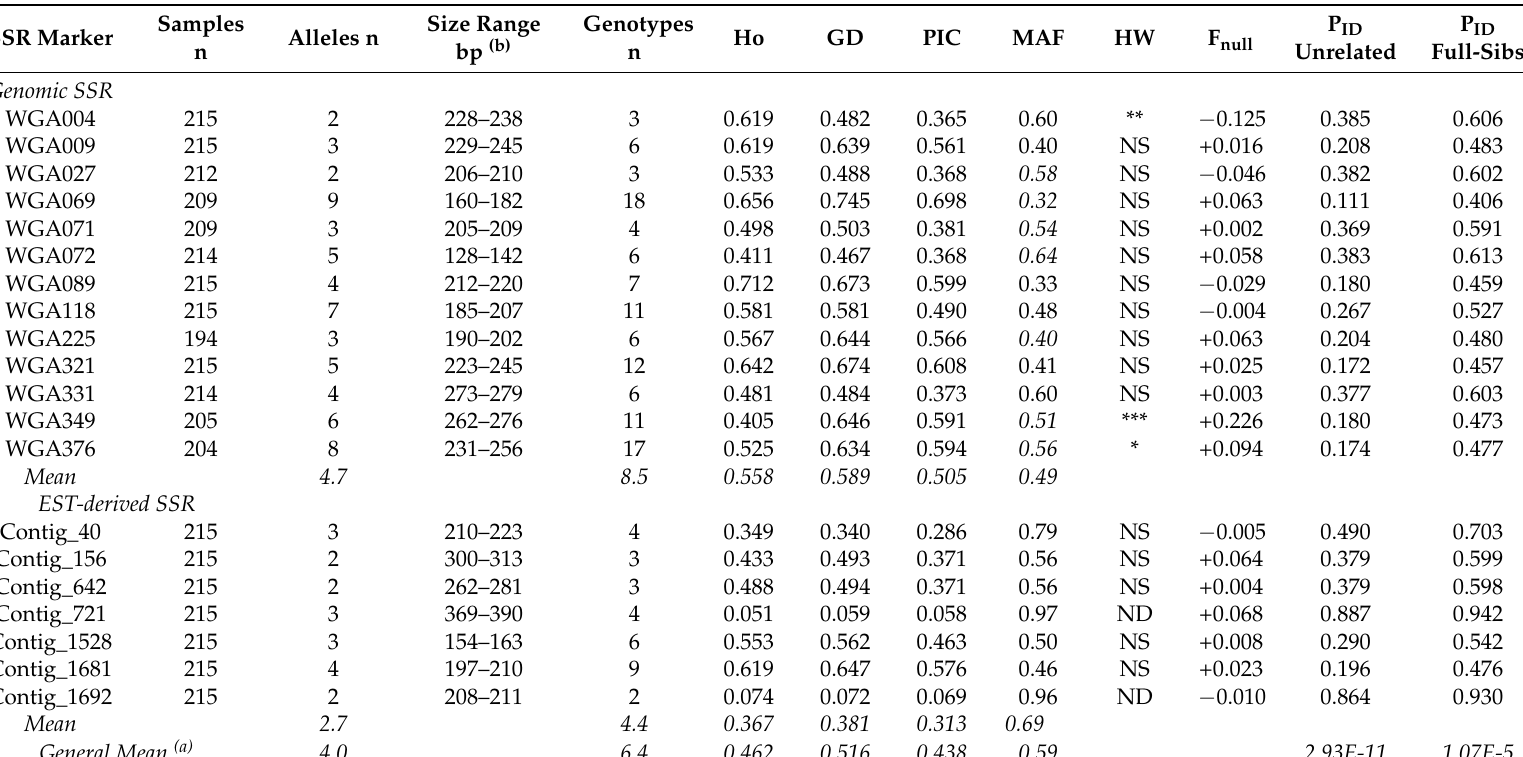
Table 2. Genetic metrics of the 20 SSR markers tested on the whole set of walnut accessions: number of alleles, allele size ranges, number of genotypes, observed heterozygosity (Ho), gene diversity (GD), polymorphism information content (PIC), major allele frequency without null alleles (MAF), Hardy-Weinberg equilibrium (HW), estimated frequency of null alleles (Fnull), and probability of identity (PID) for unrelated individuals and